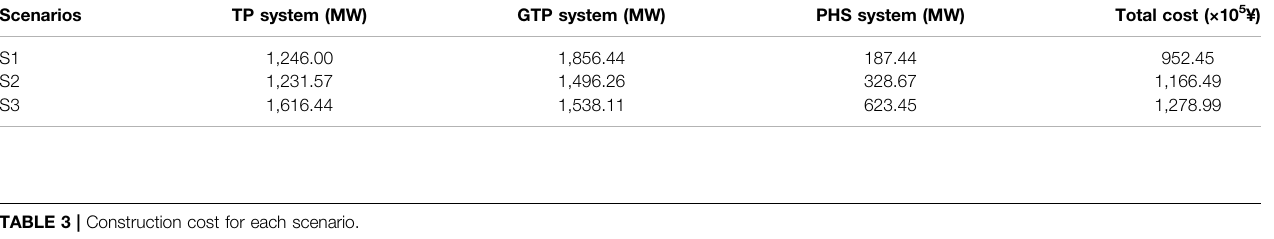
TABLE 2 | Optimal capacity con fi guration results for each scenario. Scenarios